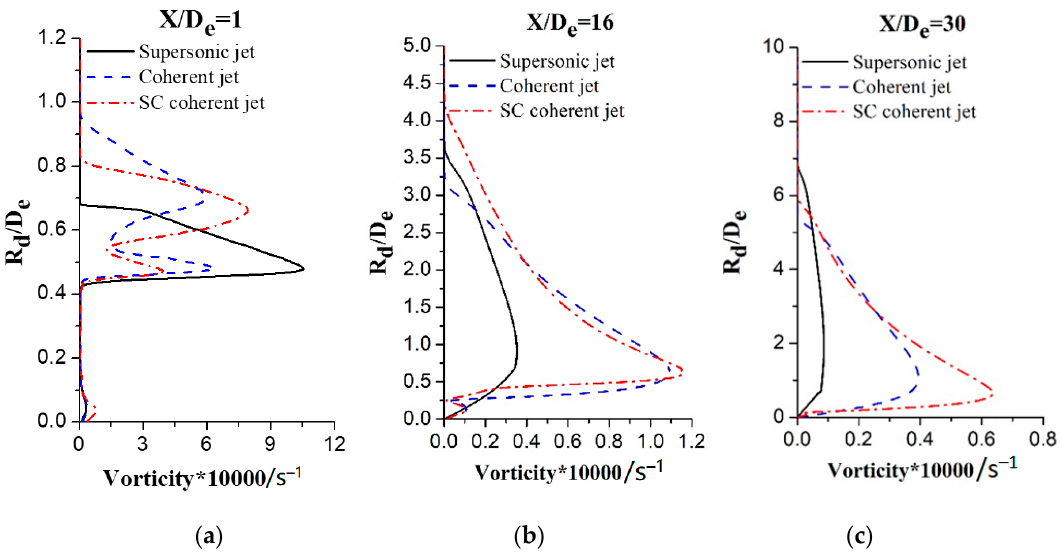
Figure10. Vorticitymagnituderadialdistributionsatdi ff erentaxiallocationsforthreejets: ( a )supersonic Figure 10. Vorticity magnitude radial distributions at different axial locations for three jets: ( a ) jet; ( b ) coherent jet; and ( c ) SC coherent supersonic jet; ( b ) coherent jet; and ( c ) SC coherent jet.